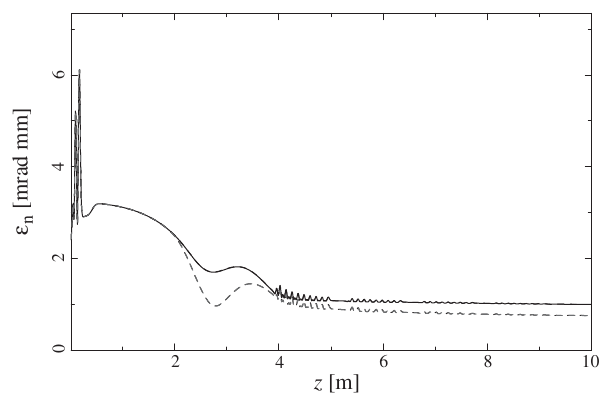
FIG. 14. Development of the projected transverse emittance in the injector. The solid line shows a standard emittance calcu- lation, while in the calculation shown as a dashed line over- focused particles have been ignored.